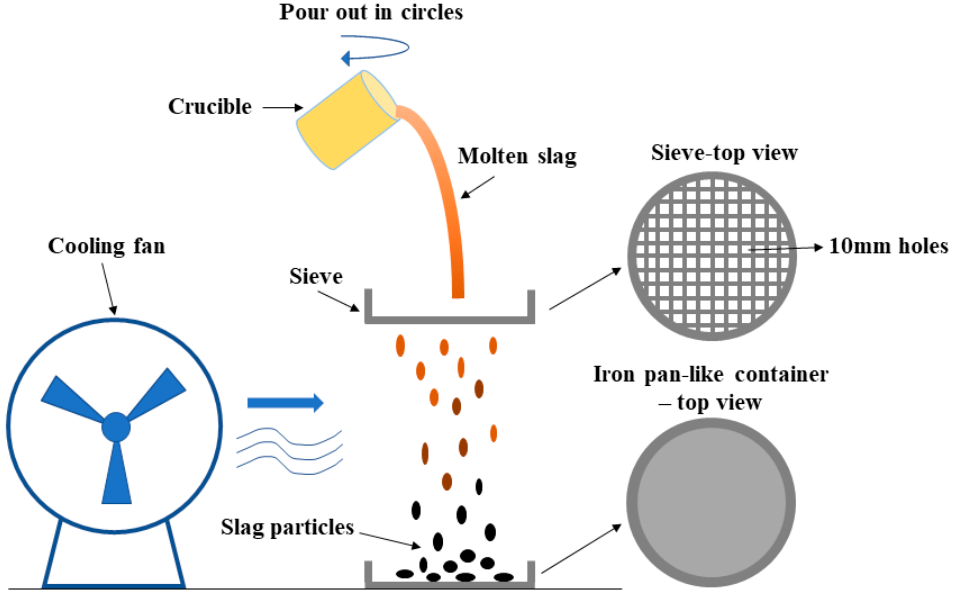
Figure 1. Schematic diagram of lab-scale simple air quenching process.